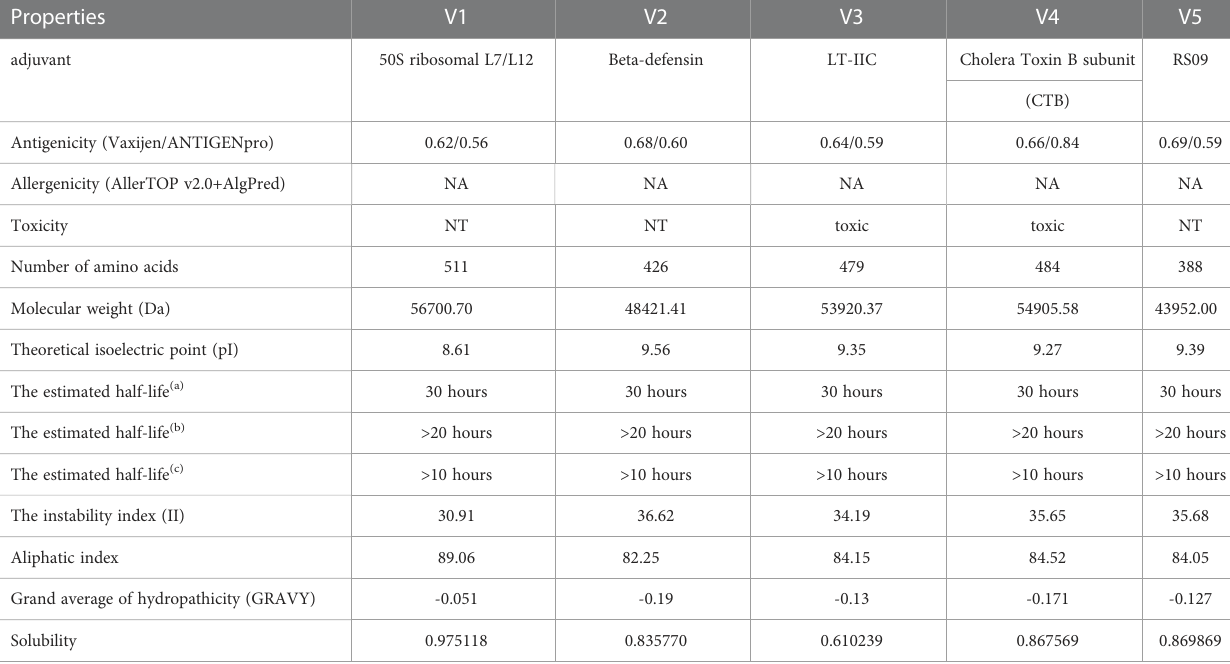
TABLE 4 Properties of the vaccine constructs.